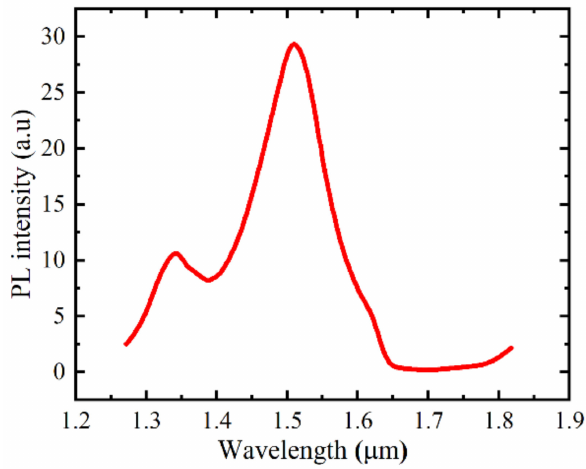
Figure 5. Room temperature µ -PL spectra of the SCH–MQW microwire with